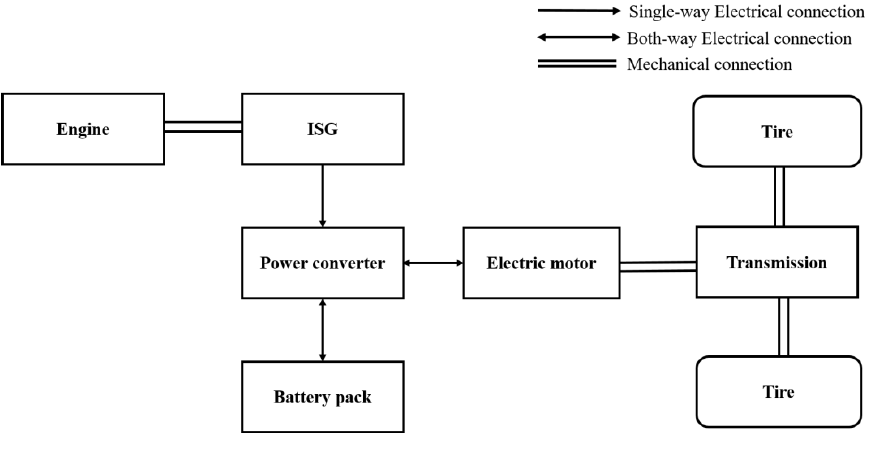
Figure 2. The powertrain architecture.